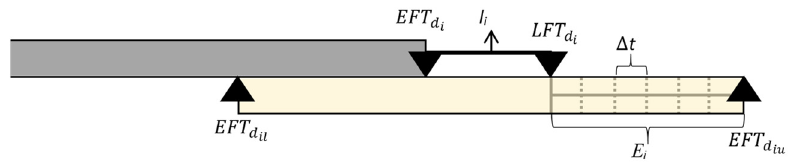
Figure 1. Graphical representation of E i and ∆ t .